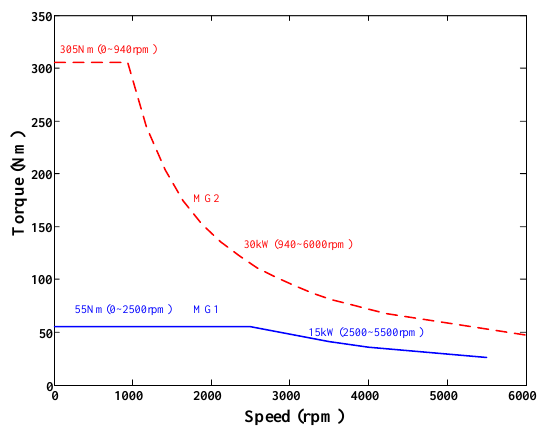
Figure 5. External characteristic curves of MG1 and MG2 in the THS.